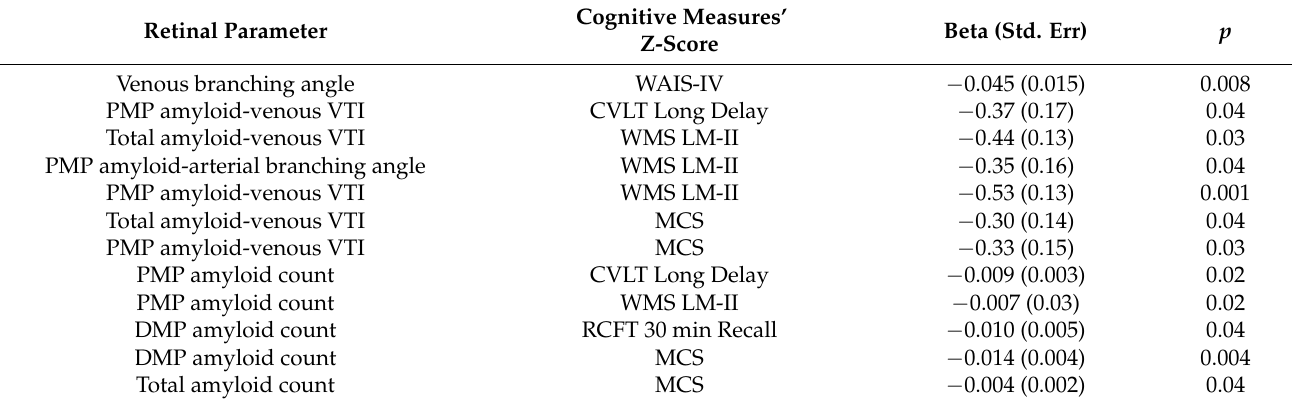
Table 3. Retinal vascular and amyloid parameter predictors of cognitive domain